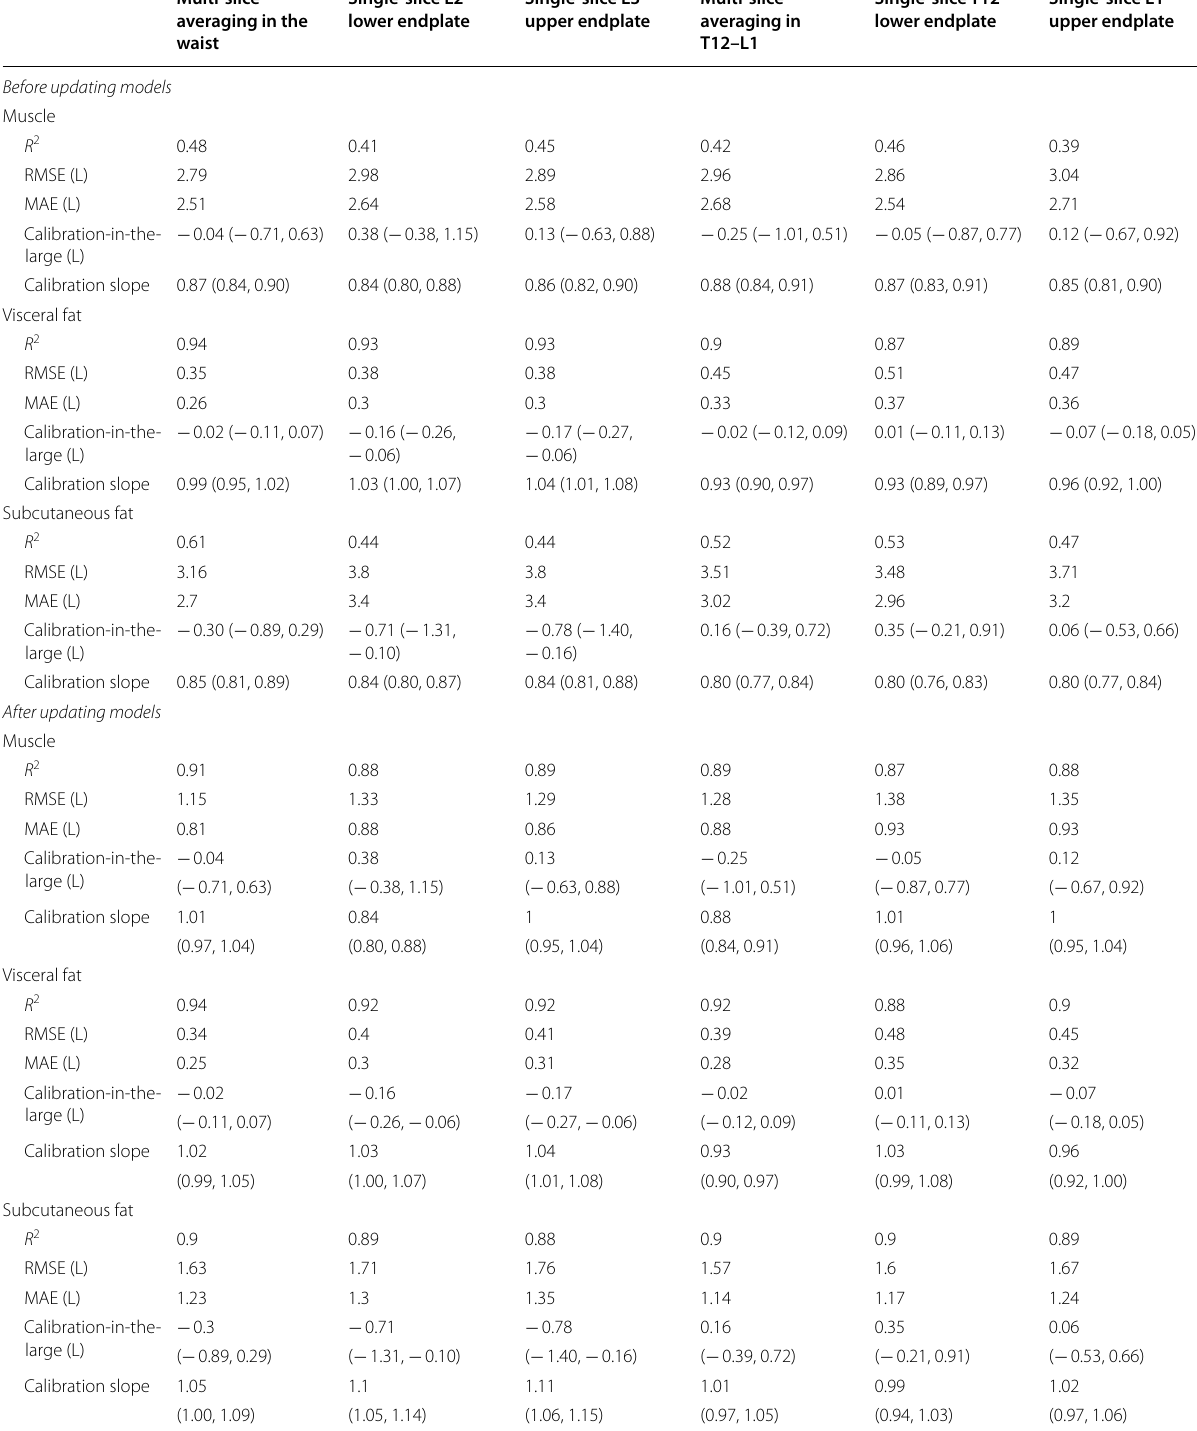
Table 3 Model performance for predicting whole‑body composition in the external